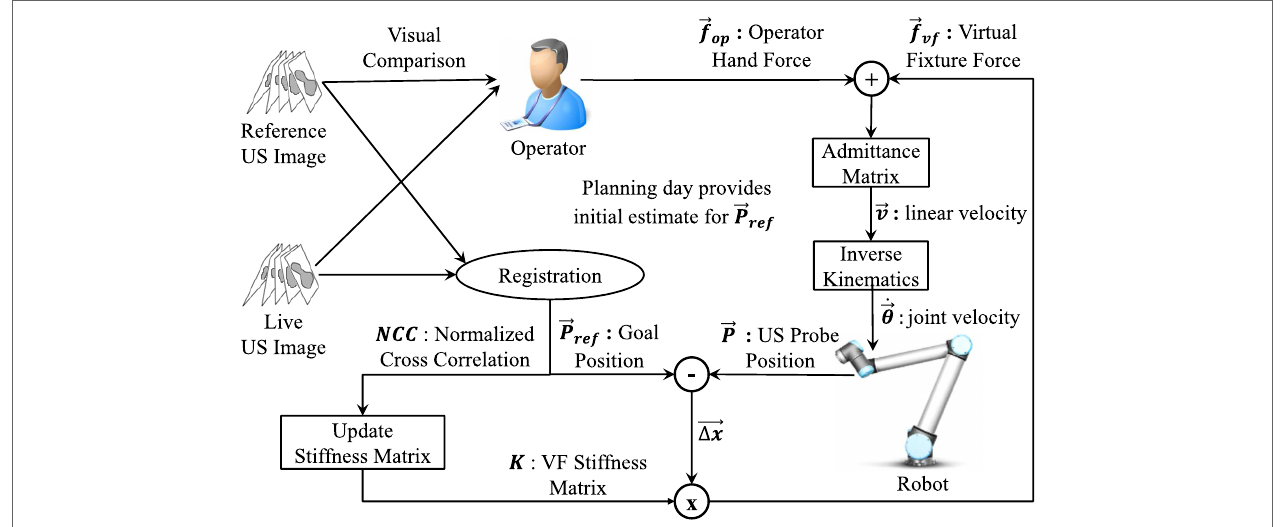
FIGURE 4 | Block diagram of ultrasound-guided co-manipulation strategy